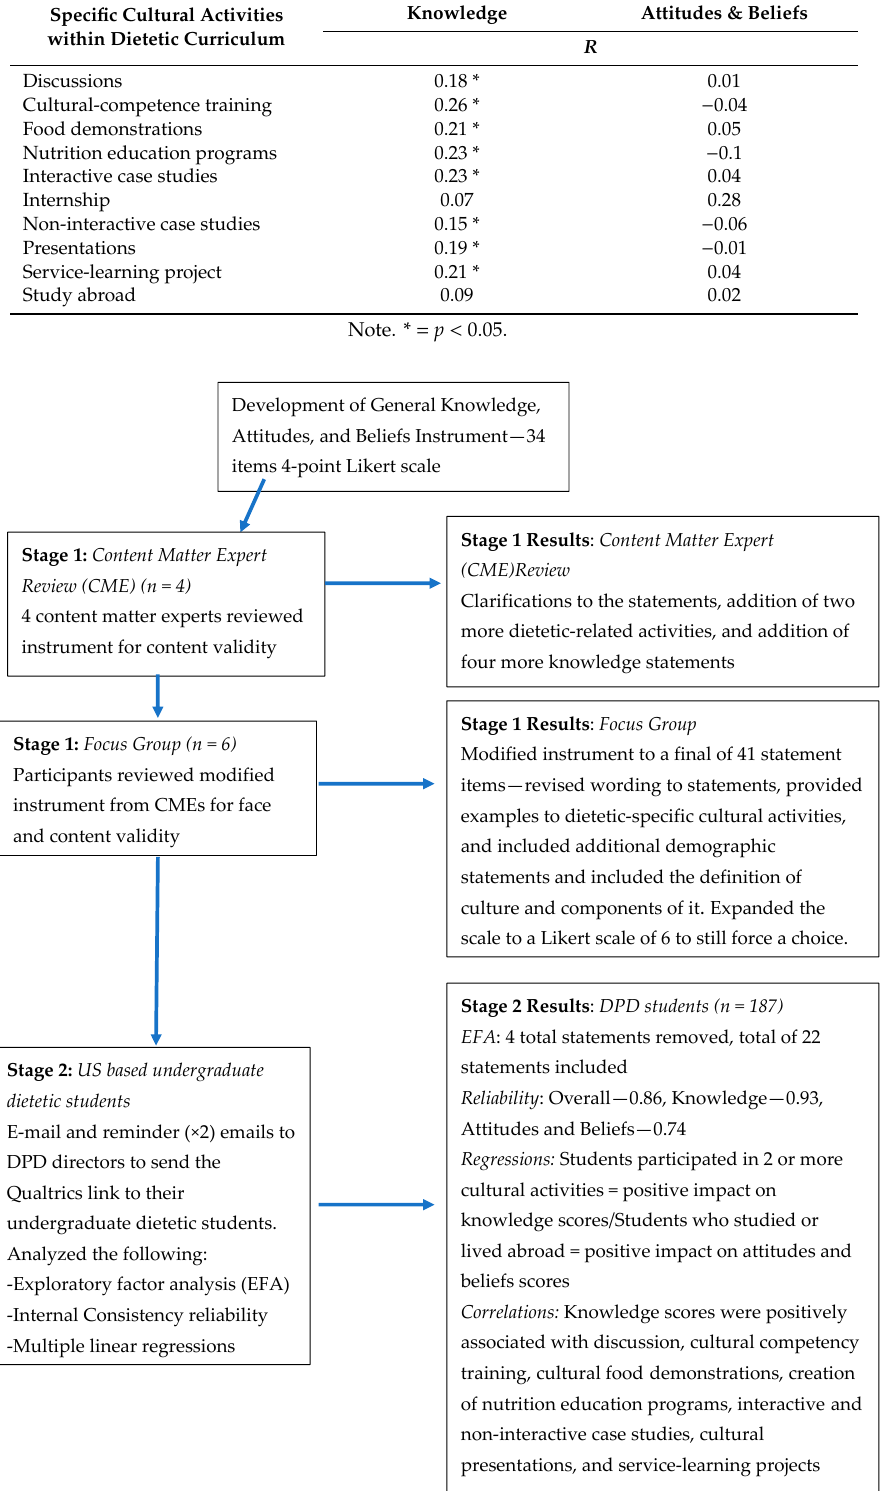
Figure 1. Stages of the study and key findings.